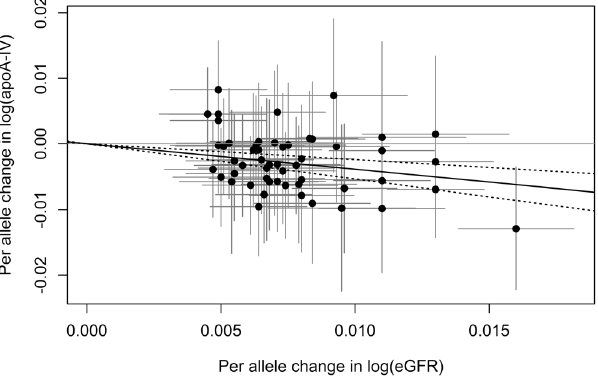
Figure 5. Scatterplot showing the effect estimates of SNP-eGFR (estimated glomerular filtration rate) associations (95% CI) on the x- and SNP-apoA-IV (apolipoprotein A-IV) associations (95% CI) on the y-axis for all 53 SNPs. The continuous black line represents the MR-IVW estimate of eGFR on apoA-IV (dashed lines represent the corresponding 95%